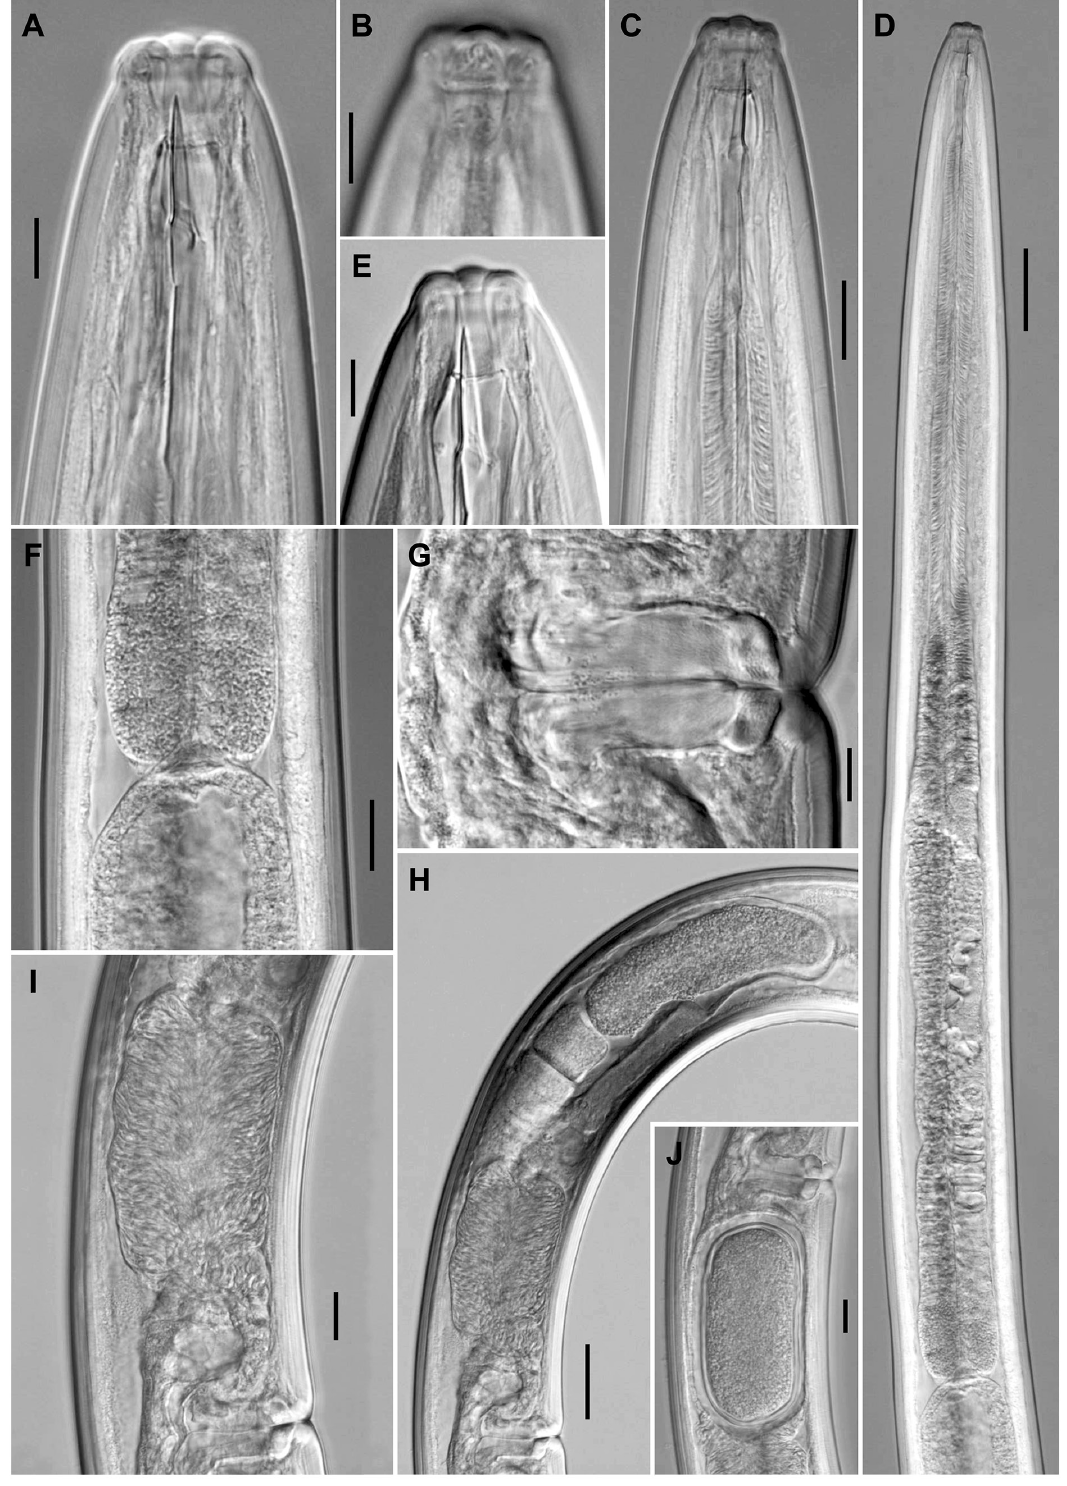
Fig. 2. Sectonema tropicum sp. nov. (LM). A , C , E . Anterior region in lateral, median view. B . Lip region in lateral, surface view. D . Neck region. F . Pharyngo-intestinal junction. G . Vagina. H . ♀, anterior genital branch. I . Vagina and anterior uterus containing sperm cells inside. J . Uterine egg. Scale bars: A–B, E, G = 10 μm; C, F, I–J = 20 μm; D, H = 50